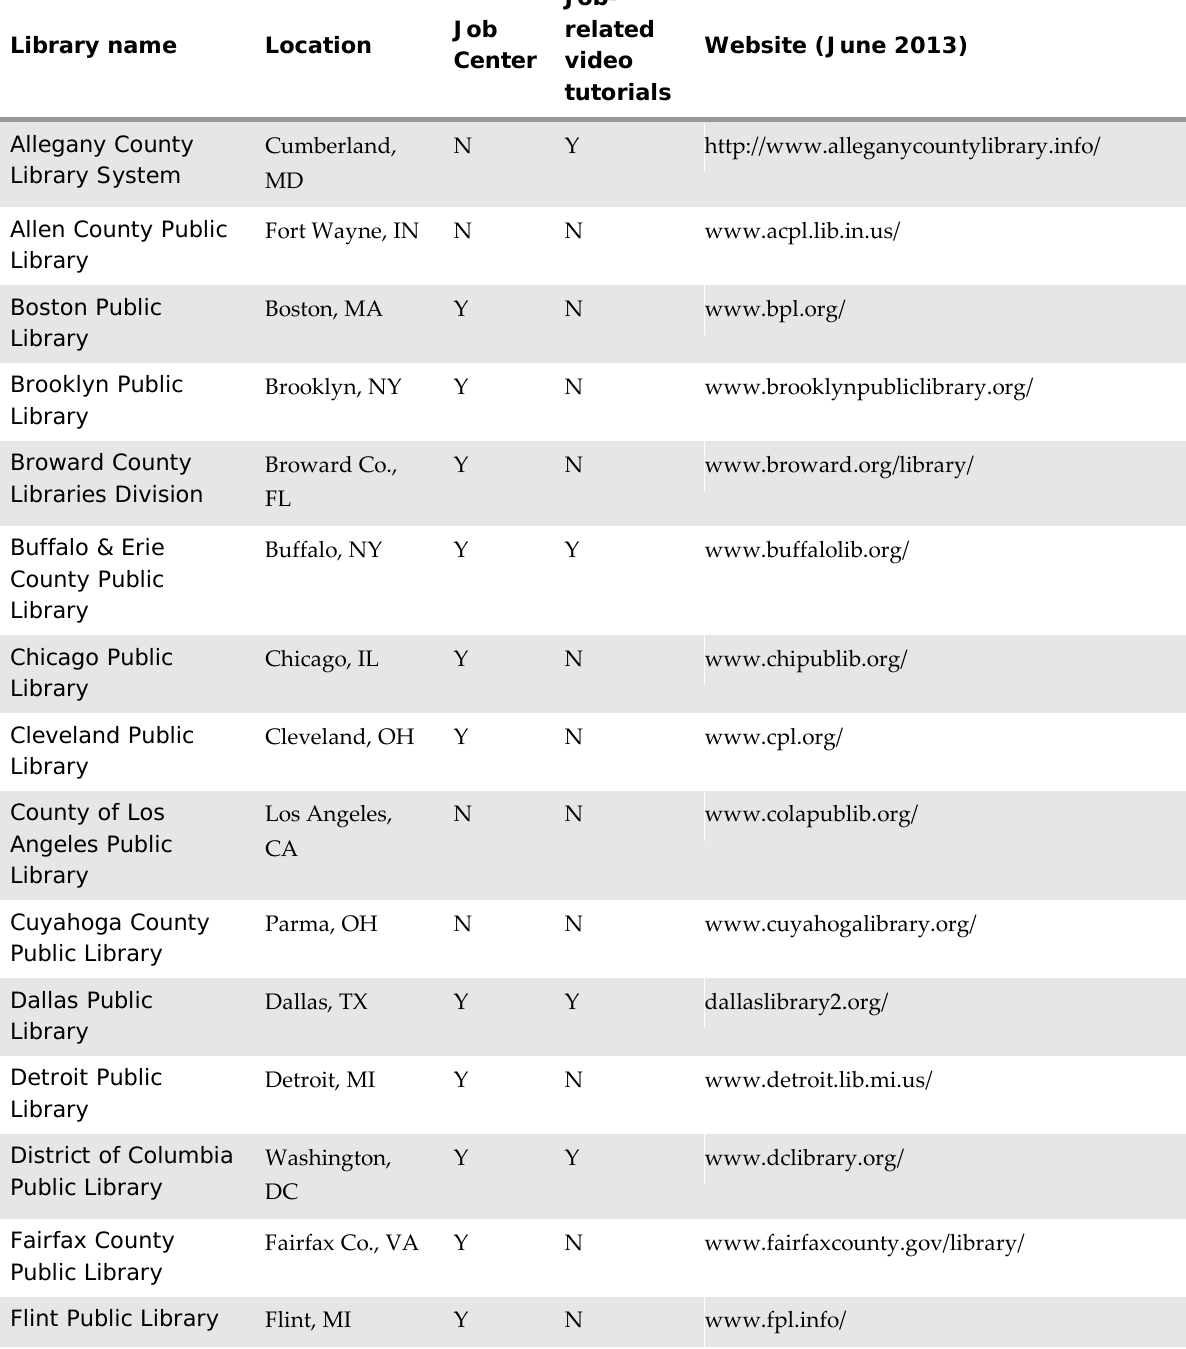
Public library websites searched for video tutorials (March 2012), showing the presence of job centers and/or video